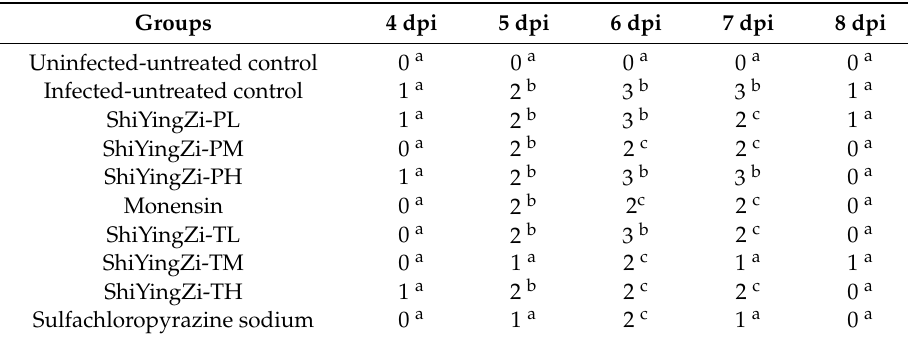
Table 2. The bloody diarrheal score from 4 to 8 dpi.